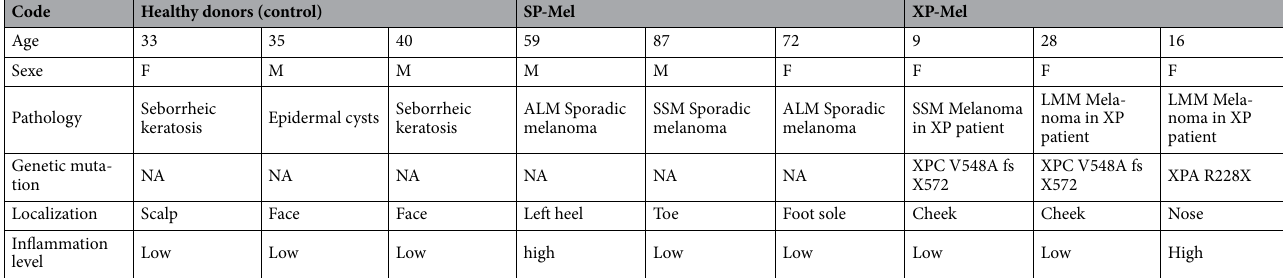
Table 1. Detailed PCR array cohort description NA = Not